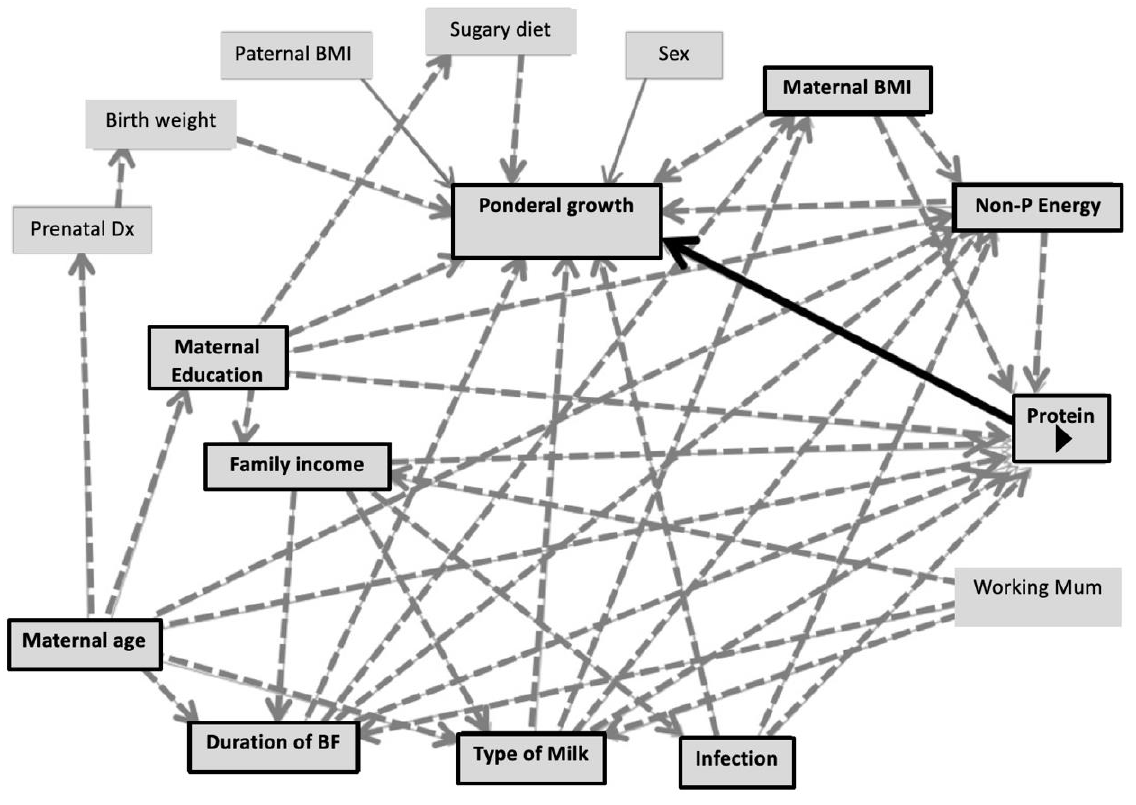
indicate causal paths between the main predictors and outcomes. Dashed-grey arrows represent bias paths. Boxes with black frames show potential confounders.